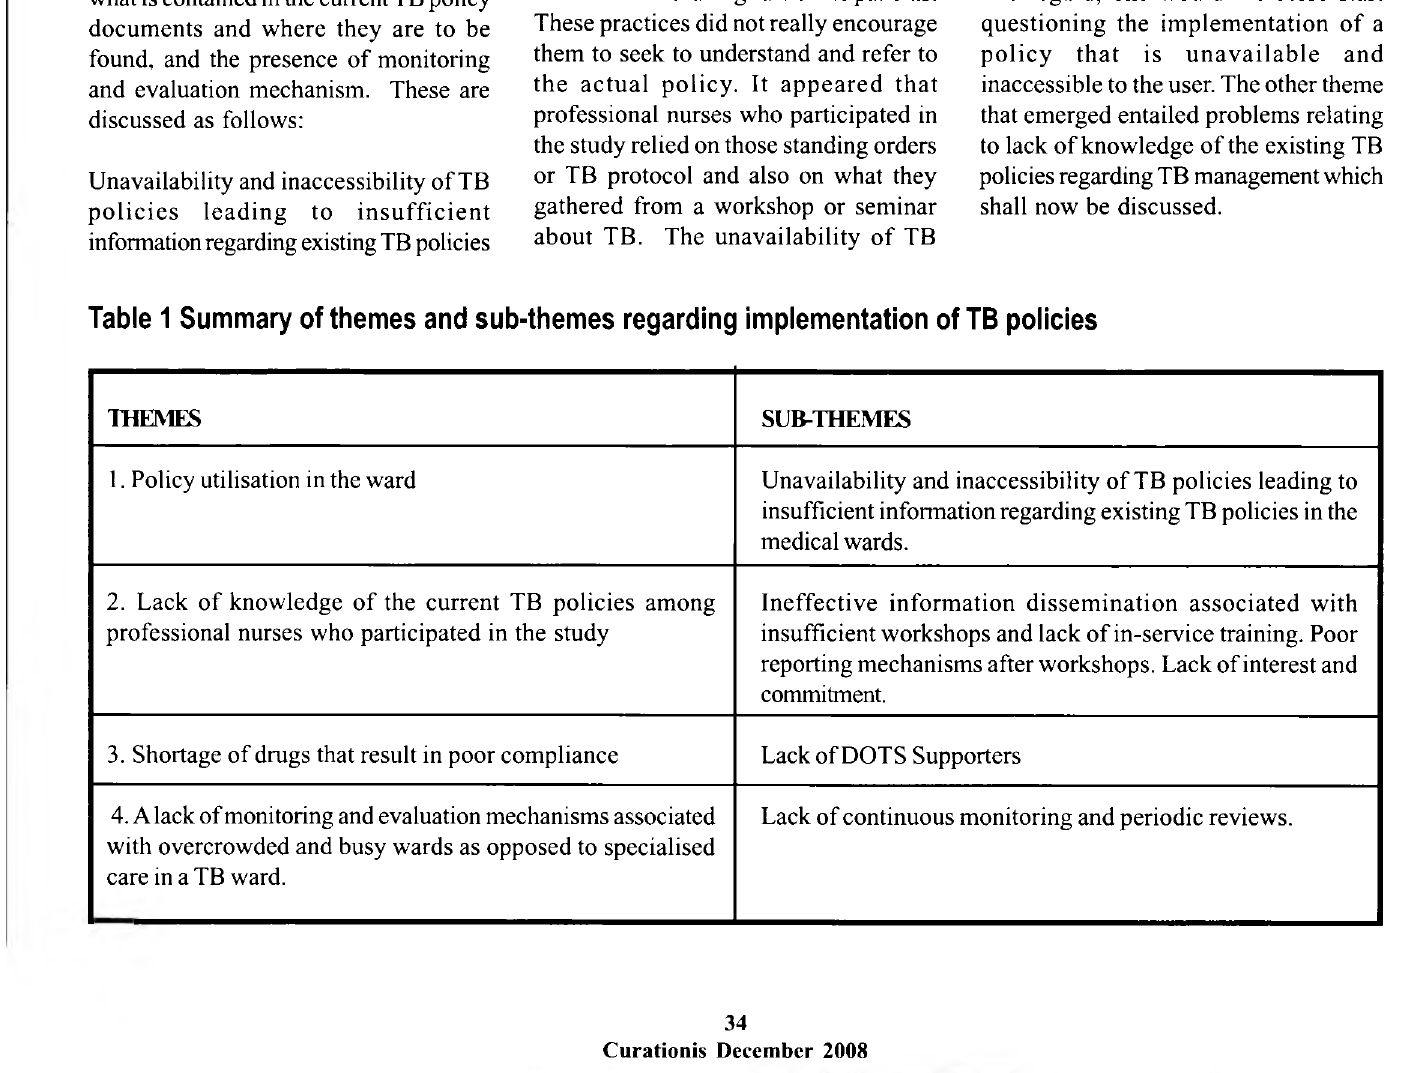
Table 1 Summary of themes and sub-themes regarding implementation of TB